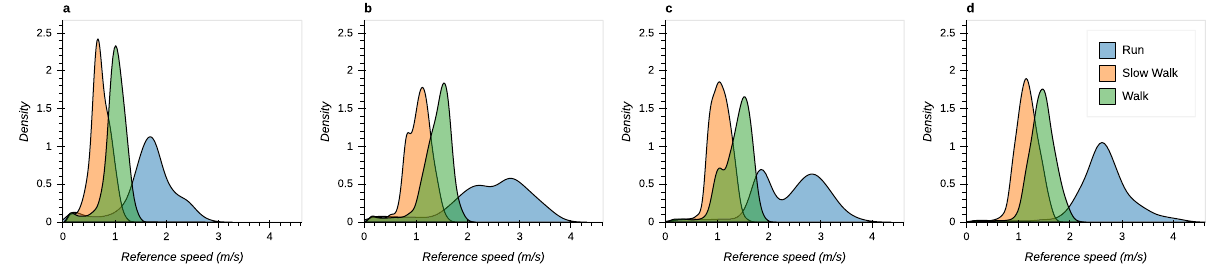
Figure 8. KDE of gold standard speed across different environments and tasks (blue: running, orange: slow walking, green: walking). ( a ) Optical tracking space. ( b ) Hallway environment. ( c ) Lobby environment. ( d ) Courtyard